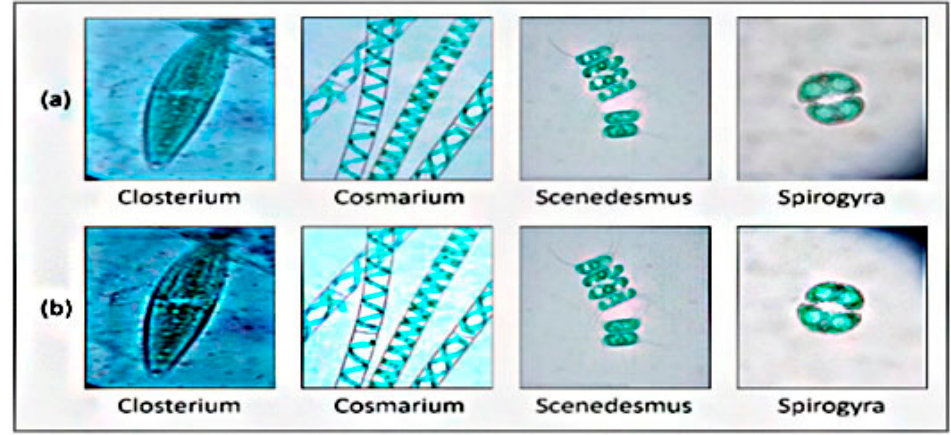
Figure 2. Example of algae samples used for multiclassification. ( a ) Original samples. ( b ) Pre ‐ pro ‐ cessed samples generated using Dc ‐ GAN.